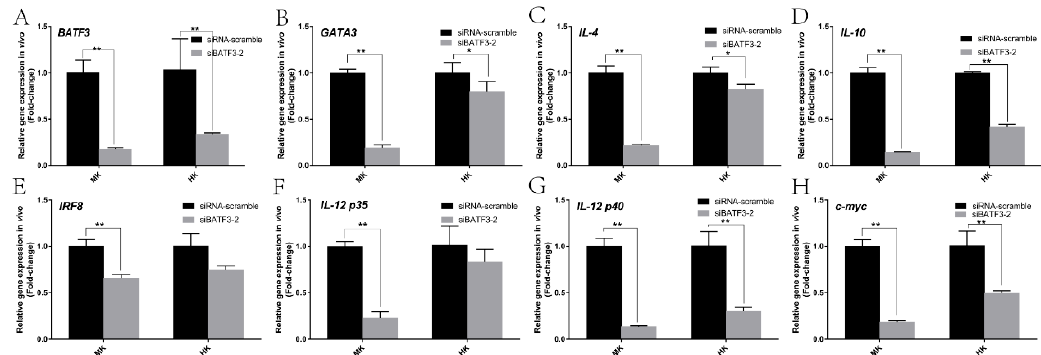
Figure 7. Gene expression profiling in head kidney (HK) and middle kidney (MK) at 24 h after injected siRNA- CiBATF3 in vivo. The expression of CiBATF3 ( A ), GATA3 ( B ), IL-4 ( C ), IL-10 ( D ), IRF8 ( E ), IL-12 p35 ( F ), IL-12 p40 ( G ) and c-myc ( H ) at 24 h were assayed by RT-qPCR. The expression level of the control group was set as the baseline (1.0) and the results are presented as the mean ± SD ( n = 3). siRNA-scramble: control siRNA infection; siBATF3: CiBATF3 siRNA infection. * = p ≤ 0.05, ** = p ≤ 0.01.